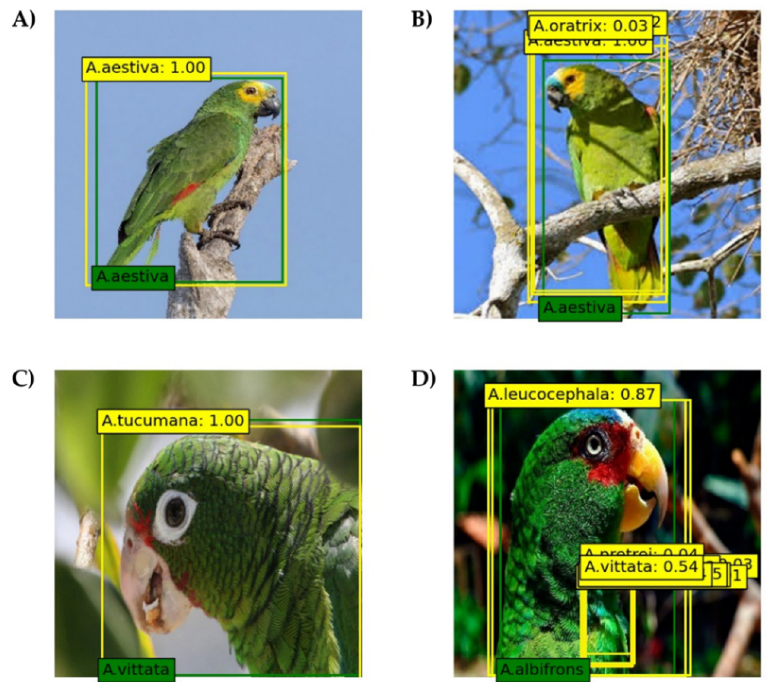
Figure 3. Representative images of four cases of model prediction results. The green and yellow boxes on the images represent ground-truth and prediction bounding boxes, respectively. The values in the yellow boxes are confidence scores provided by the models, indicating the probability of the prediction being correct. ( A ) Image of Amazona aestiva , one prediction bounding box was predicted and classified correctly; ( B ) Image of A. aestiva , multiple prediction bounding boxes were predicted and classified correctly; ( C ) Image of Amazona vittata , one prediction bounding box was predicted and classified incorrectly; ( D ) Image of Amazona albifrons , multiple prediction bounding boxes were predicted and classified incorrectly. Photo credit: ( A ) Charles J. Sharp, ( B ) Bernard Dupont, ( C ) Tom MacKenzie, and ( D )